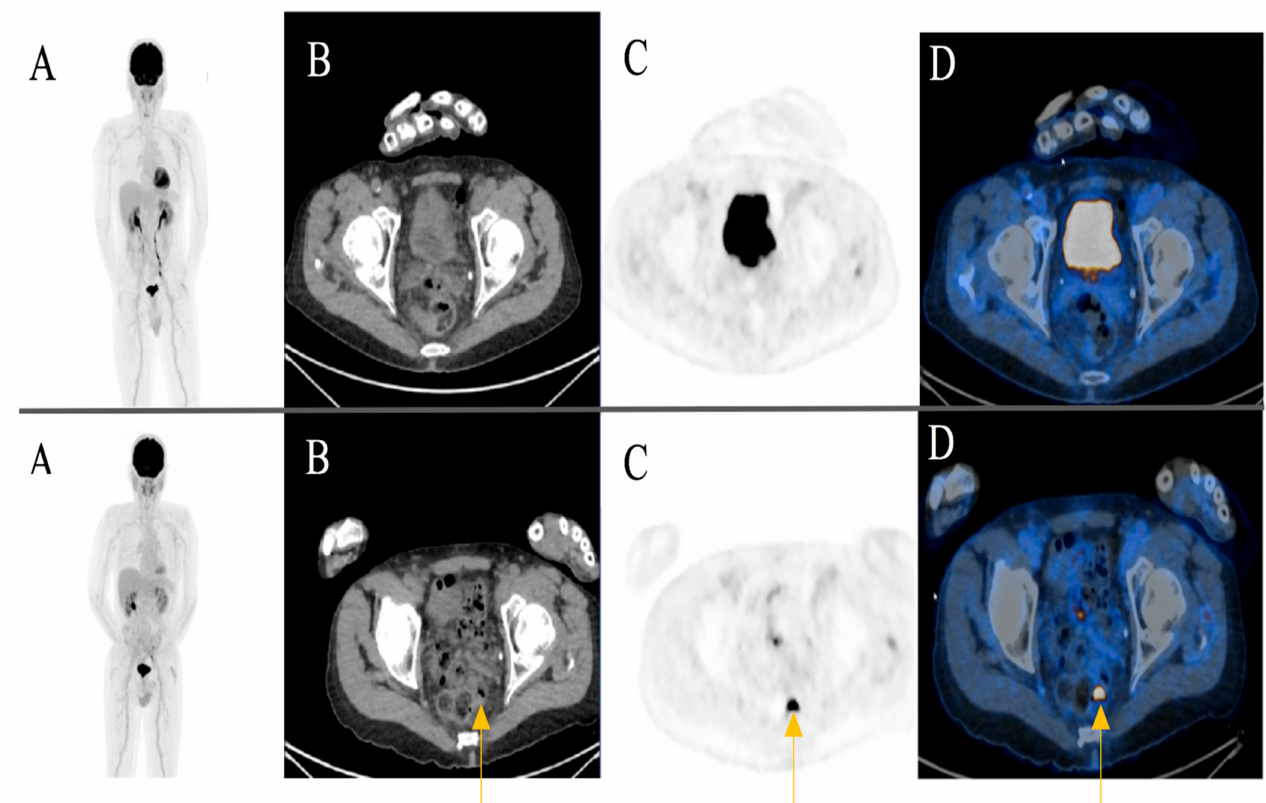
Figure 4. A 72-year-old male patient initially with metastatic cutaneous melanoma stage IIIC (T0 N2b M0). ( A ) Maximum intensity projection (MIP); ( B ) Computed Tomography (CT) axial of pelvis; ( C ) Positron Emission Tomography (PET) axial of pelvis; ( D ) Fused images PET/CT axial of pelvis. First row: FDG-PET/CT performed for extended staging after left axillary lymphadenectomy without evidence of metabolically active melanoma, nodal or distant metastasis. Second row: Follow-up for treatment response assessment under anti-PD1 monotherapy. Three months after treatment initiation, a new metabolically active wall thickening of the rectosigmoidal colon was seen (yellow arrow). A rectoscopy was subsequently recommended for further evaluation. The biopsy revealed a well-differentiated adenocarcinoma of the